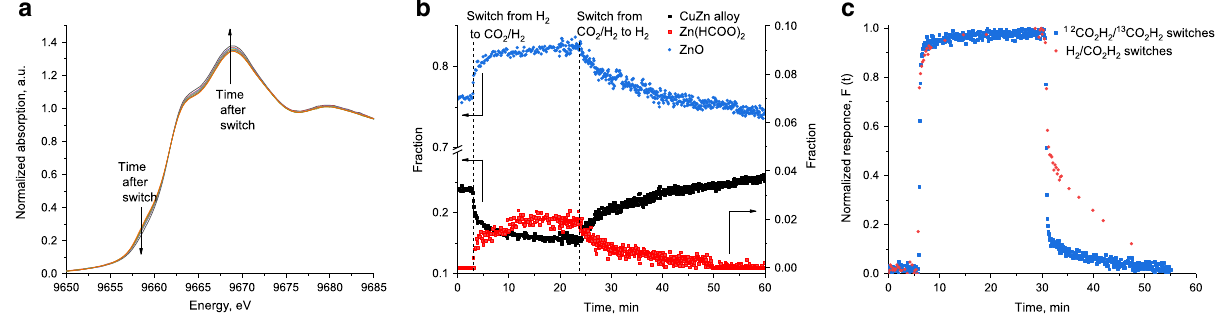
Fig. 2 Results of operando XAS experiment. a Time-resolved Zn K-edge XANES spectra evolution during operando switch from pure hydrogen to CO 2 /H 2 gas reaction mixture at 15 bar and 533 K over CZA catalyst. b The relative fractions of zinc oxide wurtzite, zinc formate and copper – zinc alloy determined from PCA analysis of XANES spectra as function of time after switch from hydrogen to CO 2 /H 2 mixture and back at 533 K and 15 bar over CZA catalyst. c Normalized transient response curves of formate species from the FTIR experiment during 12 CO 2 H 2 / 13 CO 2 H 2 (blue) and H 2 / 12 CO 2 H 2 (red) switches at 533 K and 15 bar over CZA